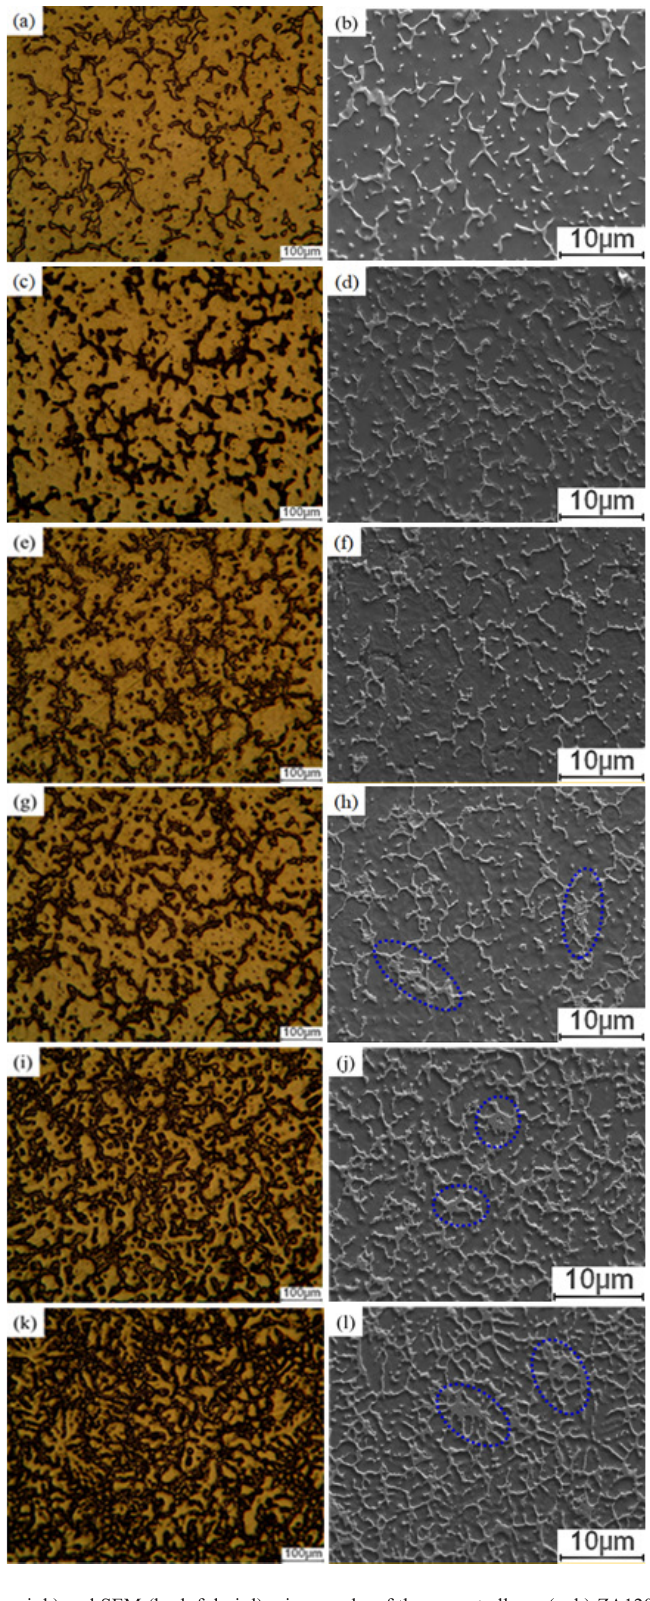
Figure 3 - Optical (a, c, e, g, i, k) and SEM (b, d, f, h, j, l) micrographs of the as-cast alloys: (a, b) ZA120 alloy; (c, d) ZA122 alloy; (e, f) ZA124 alloy; (g, h) ZA126 alloy; (i, j) ZA128 alloy; (k, l) ZA1210